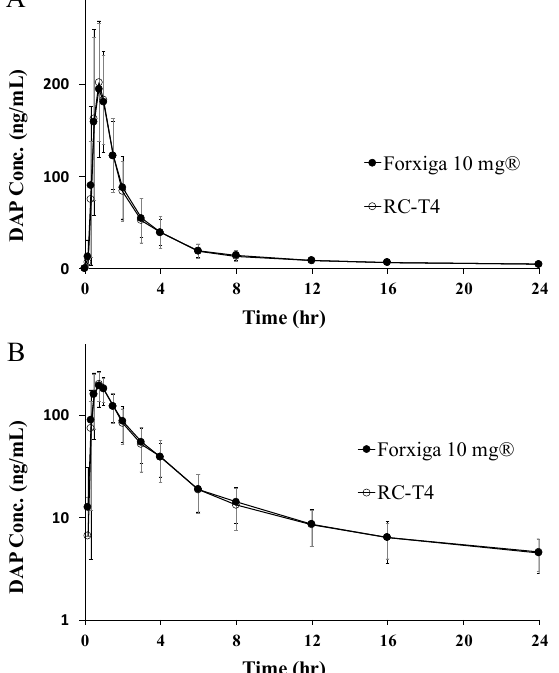
Figure 6. Average plasma concentration vs. time profiles of dapagliflozin (DAP) after oral admin- istration of Forxiga 10 mg ( ● ) and RC-T4 ( ○ ) in healthy volunteers (( A ): linear scale, ( B ): semilog scale). Each value represents the mean ± standard error ( n = 37).